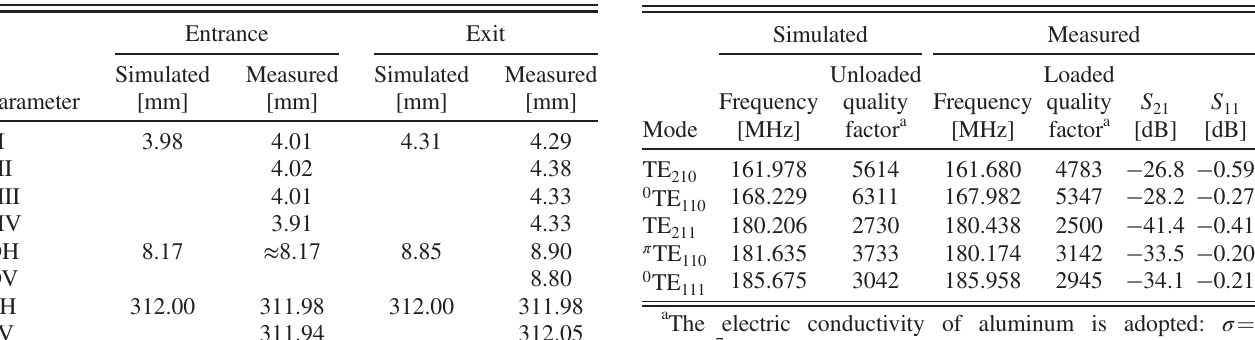
TABLE VI. Comparison of the simulated and measured param- eters of the cold